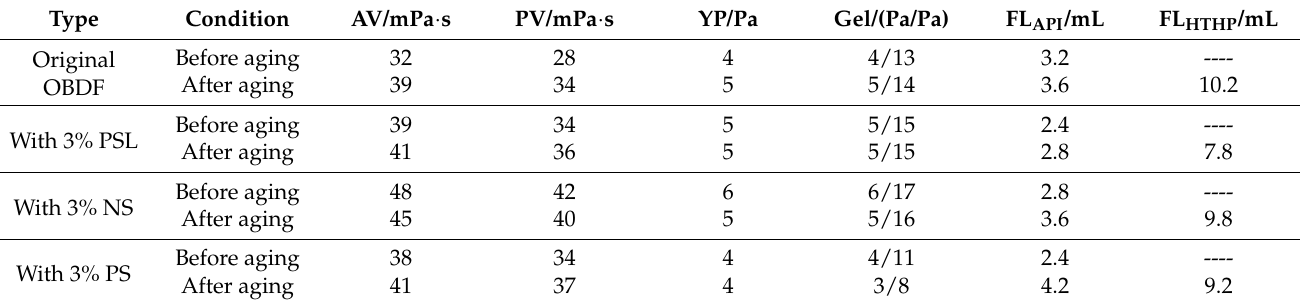
Table 2. Rheological and filtration properties of ODF with different nanoparticles before and after aging at 180 ◦ C for 16